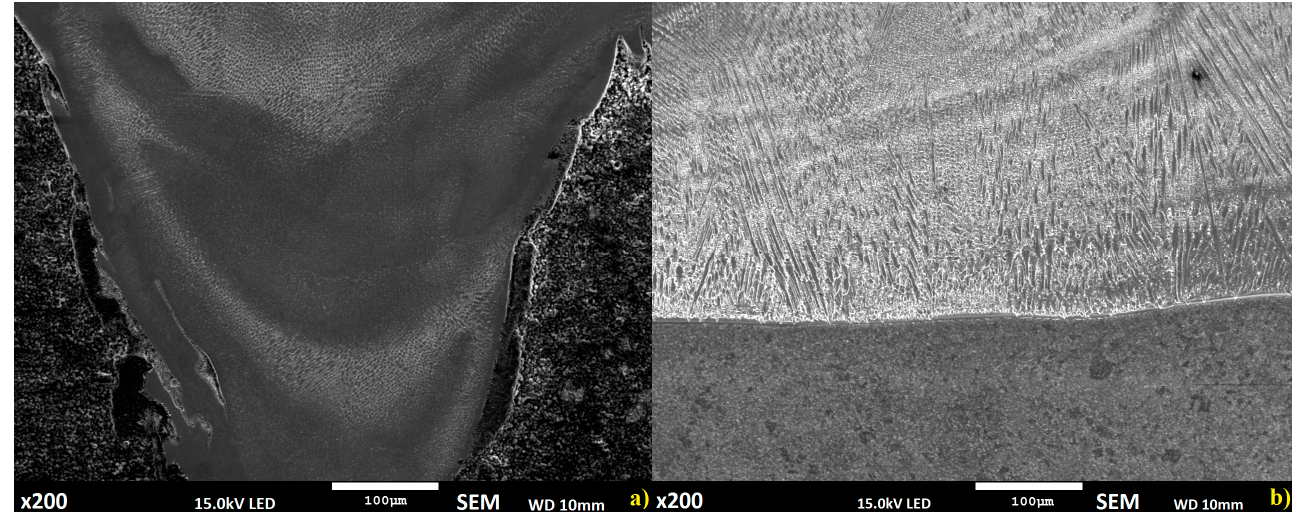
Figure 4. Structure of fusion zone between the substrate and deposited layers: ( a ) laser wire deposition method, ( b ) semi-hybrid and powder deposition methods.